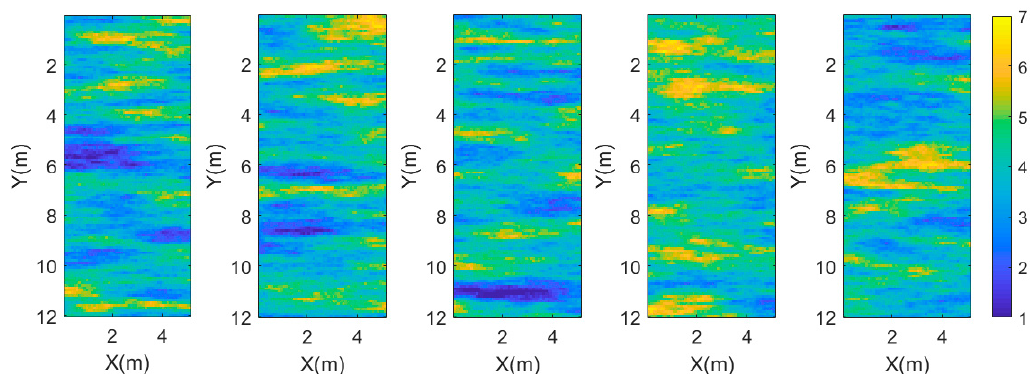
Figure 5. Five sampling models of the priori probability